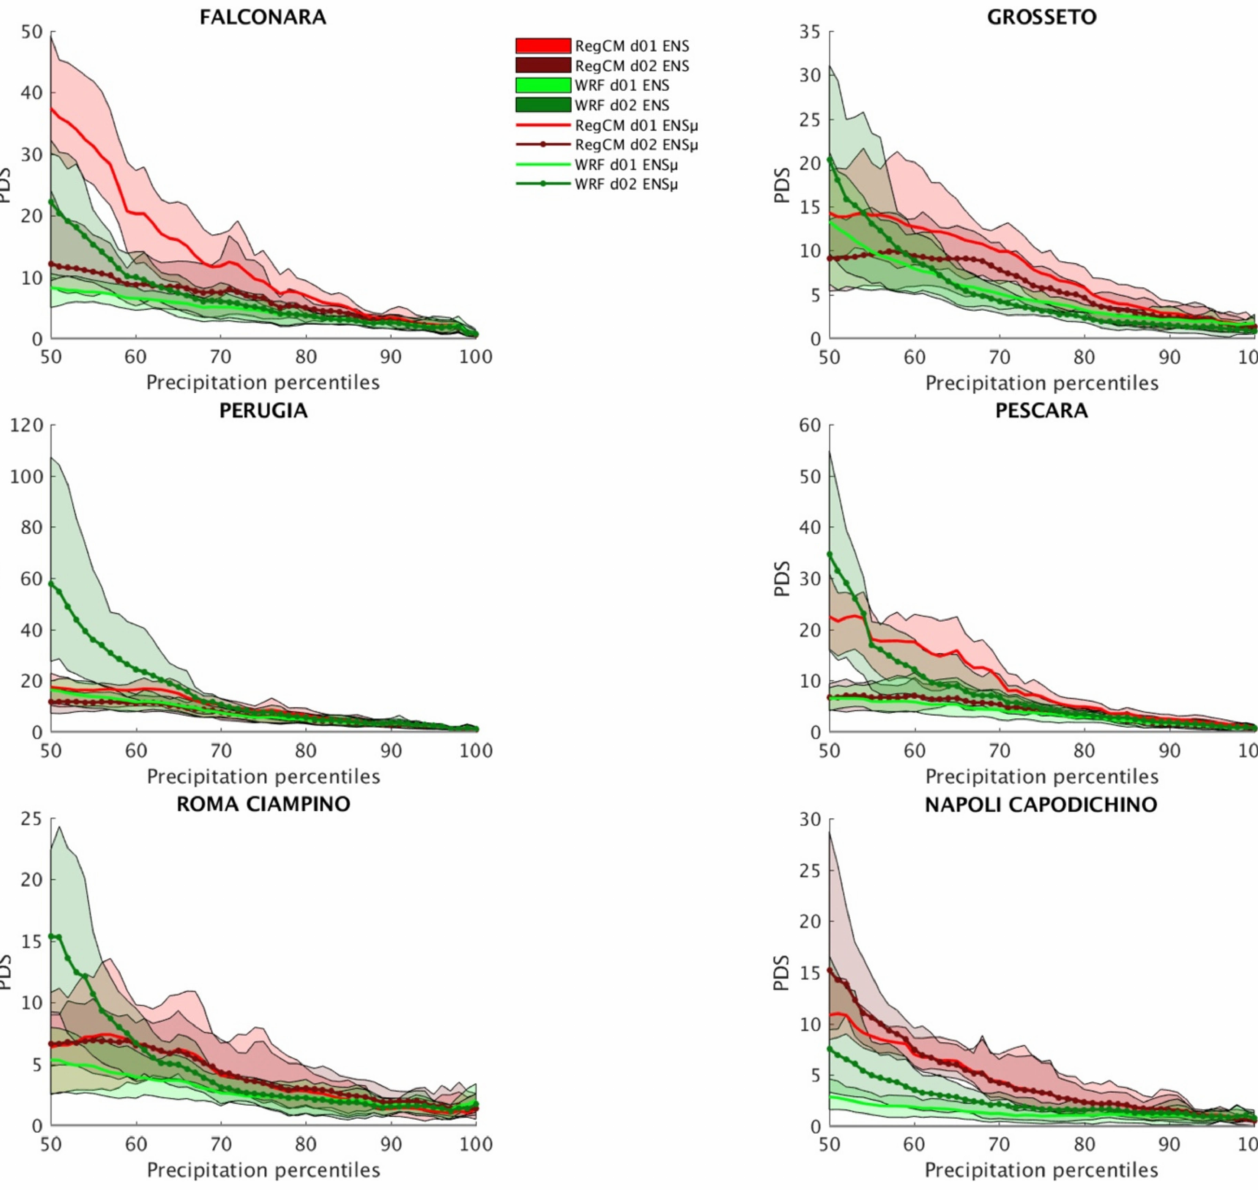
Figure 12. Same as Figure 10, but for